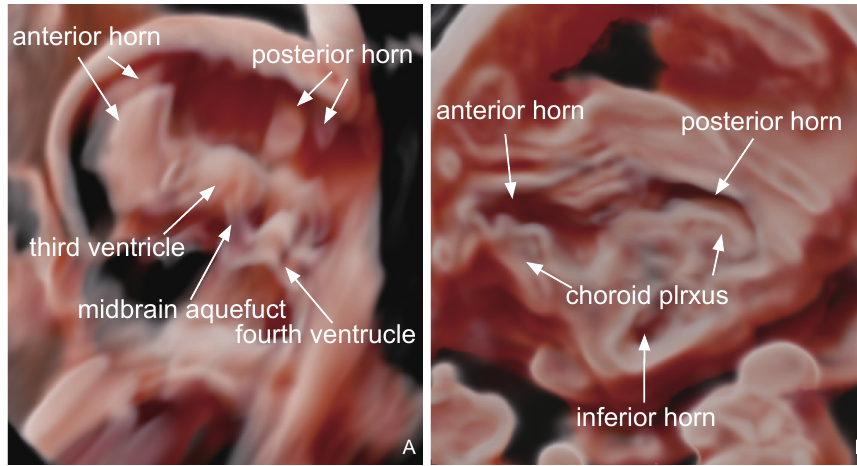
Figure 1 (A) Visualization of foetal ventricular in early-pregnancy; (B) Visualization of foetal ventricular in